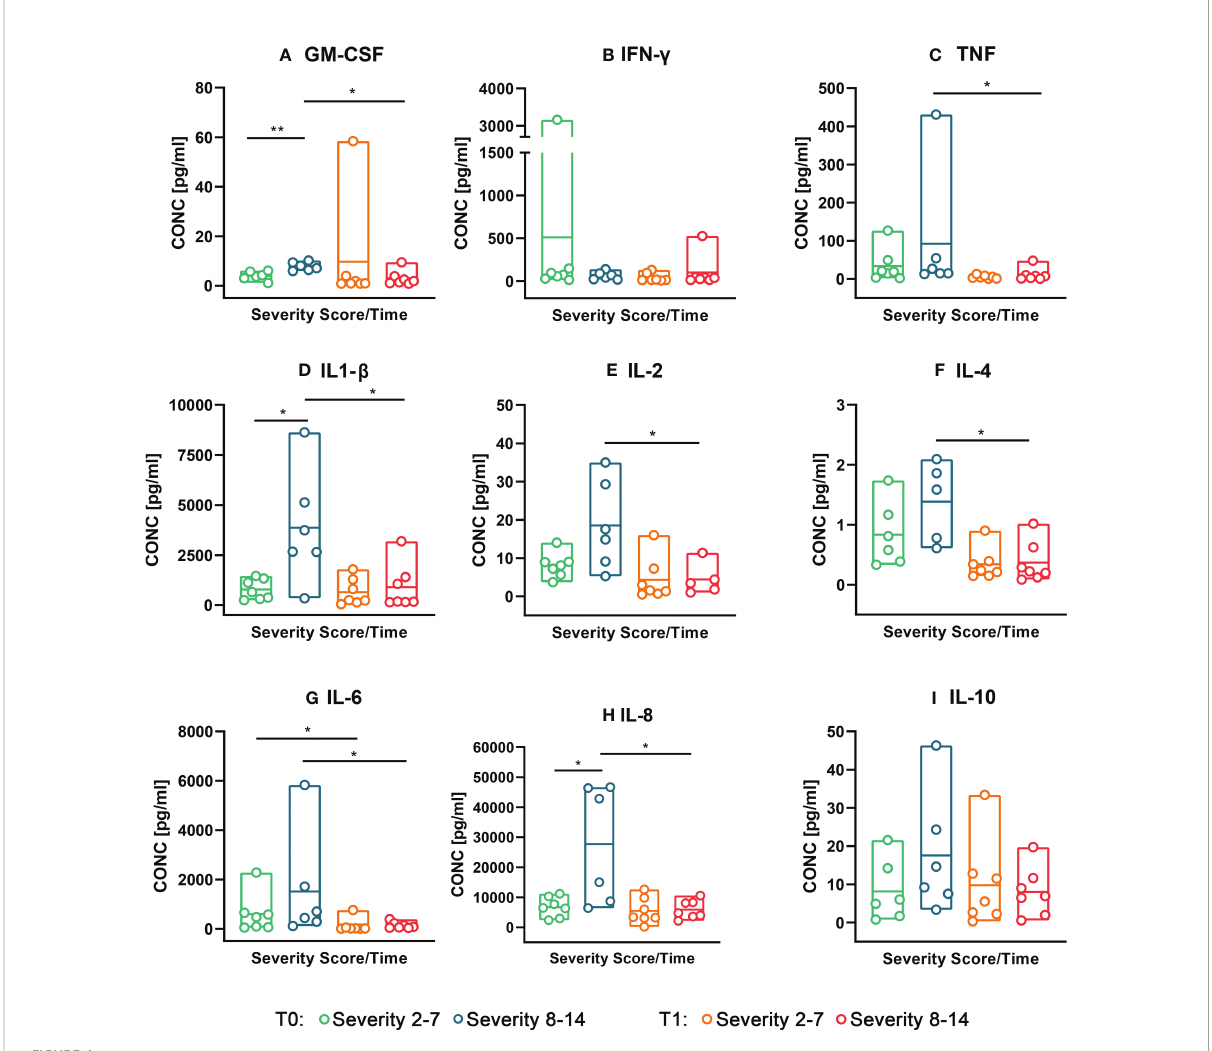
FIGURE 4 Concentrations (pg/ml) of measured cytokines (Granulocyte-macrophage colony-stimulating factor = GM-CSF, Interferon gamma = INF-y, Tumor-necrosis-factor = TNF, Interleukin (IL)-1ß/-2/-4/-6/-8/-10) in neonates with low cleft severity (Severity 2-7) compared to neonates with high cleft severity (Severity 8-14) at both time points (T0 = after birth, T1 = 4-5 weeks after birth). A colour scheme represents each group – time point – combination (Severity 2-7 T0: = green, Severity 8-14 T0 = blue, Severity 2-7 T1 = orange, Severity 8-14 T1 = red). The concentrations (pg/ml) of the measured cytokines (GM-CSF, INF-y, TNF, IL-1ß/-2/-4/-6/-8/-10) are given from the top left to the bottom right histogram (A-I) . Floating bars (max to min) with dots represent the cytokine concentration distributed in two subsets (Severity 2-7 and Severity 8-14) and both time points (T0 vs. T1). The horizontal line in the bars represents the mean. The statistical analysis was made with Mann-Whitney U-Test, *p value ≤ 0.05, **p ≤